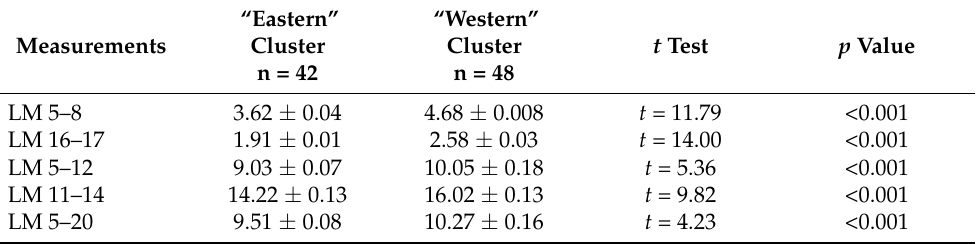
Table 3. A comparison of the linear size of the voles’ mandible between the eastern and western clusters of the forms under study.